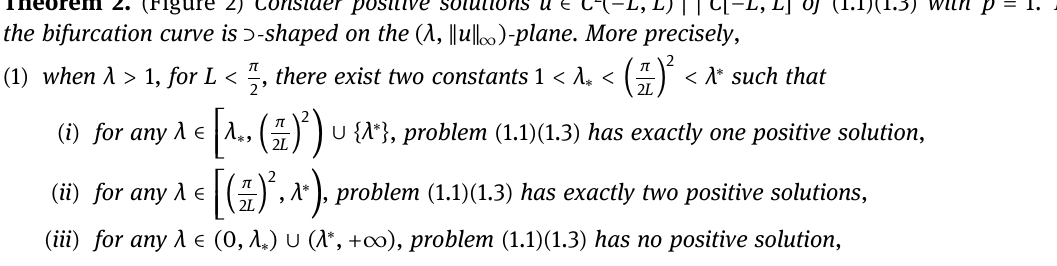
Figure 3: Bifurcation curves with = p 1 . ( a ) Exactly decreasing shaped, for < ≤ ∗ L L 0 ( b ) Reversed S - like shaped, for > ∗ L L